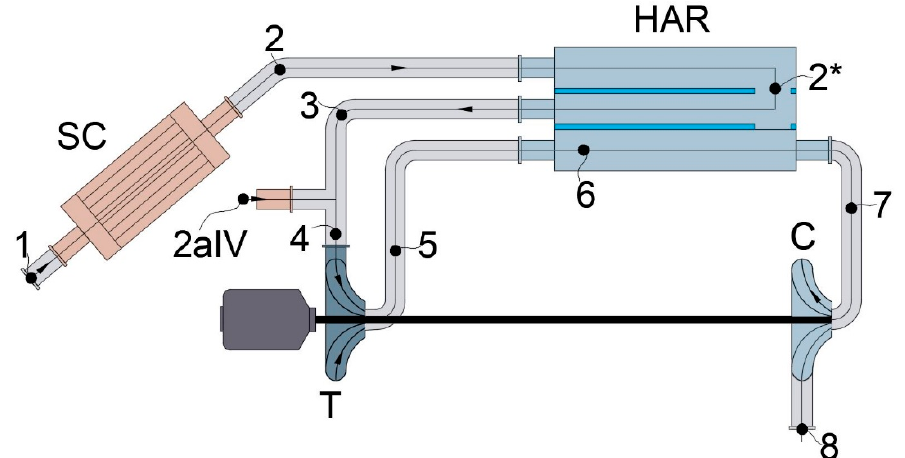
Figure 4. Brayton’s sub-atmospheric inverse cycle with HAR. SC—solar collector; HAR—humidified air recuperator; T—turbine; C—compressor; 1–8—points for determining state parameters of the flow within the processes in the cycle: 1–2—heating in SC; 2–2*—cooling in dry channels of the HAR; 2*–3—humidifying in wet channels of the HAR; 2aIV-3–4— mixing 2aIV and 3 flows that result in flow 4–5—expansion in T; 5–6—cooling of the flow to its dew point perature; 6–7—water vapor condensation from the flow in product channels of the HAR; 7–8—compression in C.